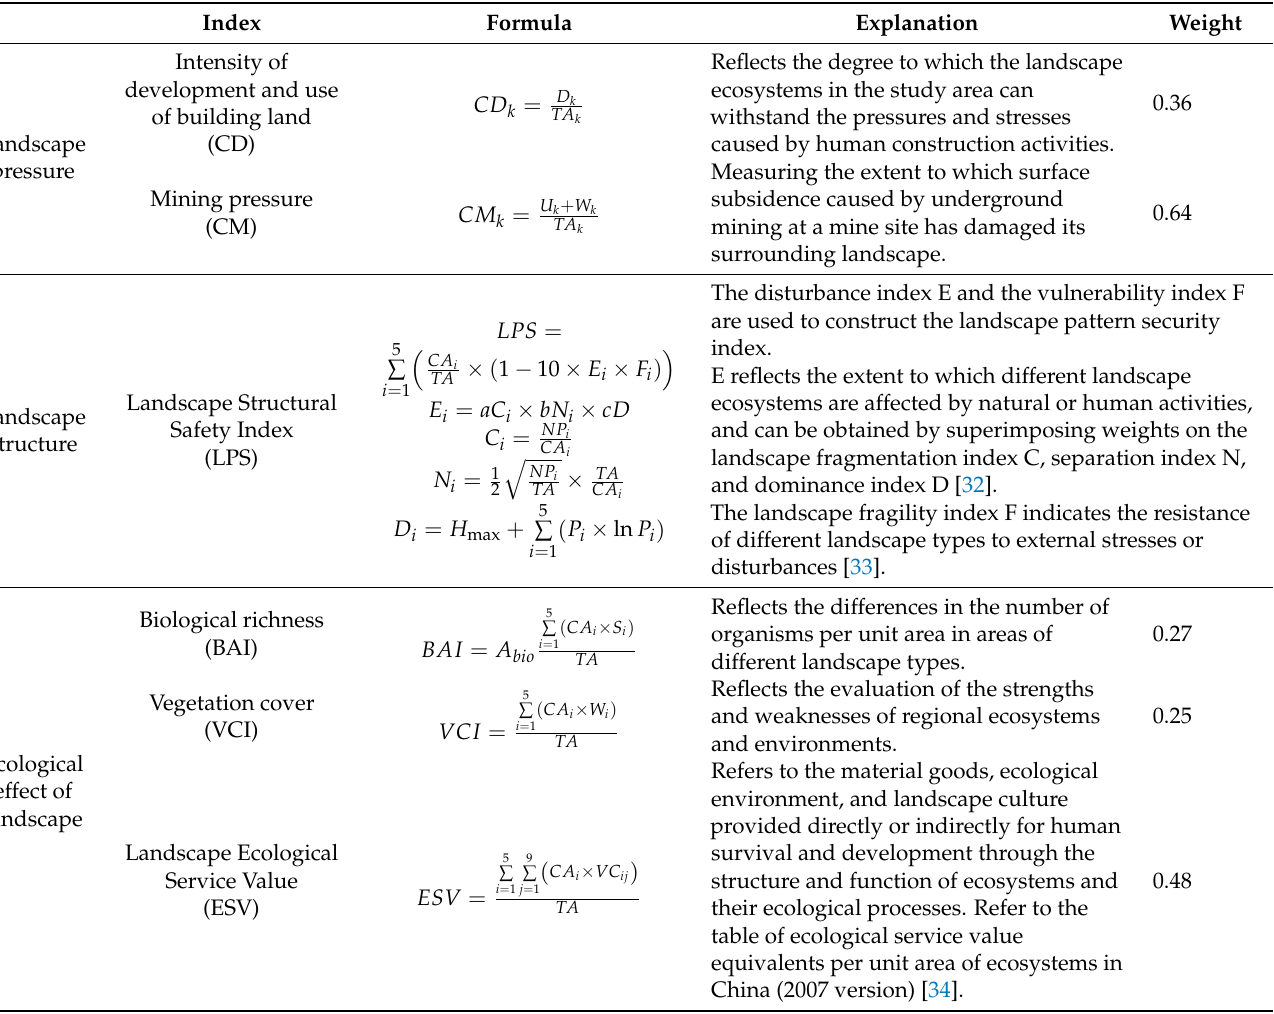
Table 2. Evaluation index system and corresponding index weights of landscape ecological security in Zhaogu mining